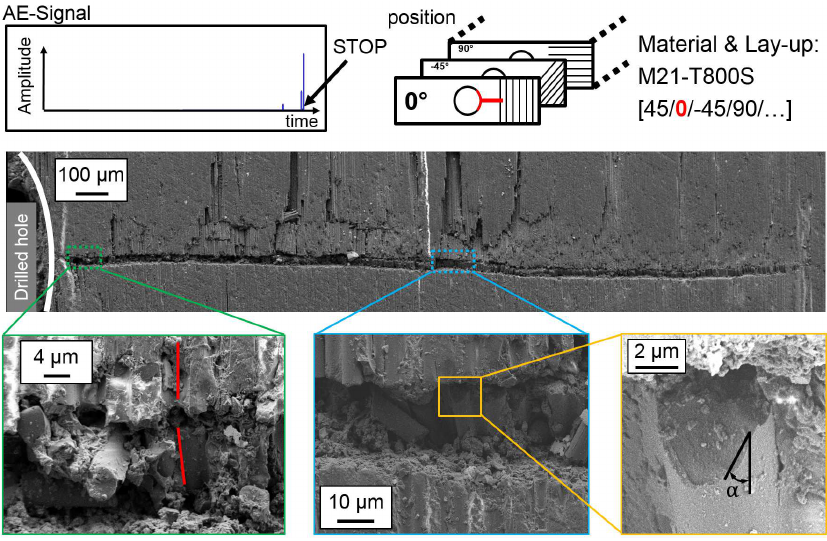
Figure 8. Damage initiation in the outer 0°-layer at the hole in a representative 977-2-IMS specimen.